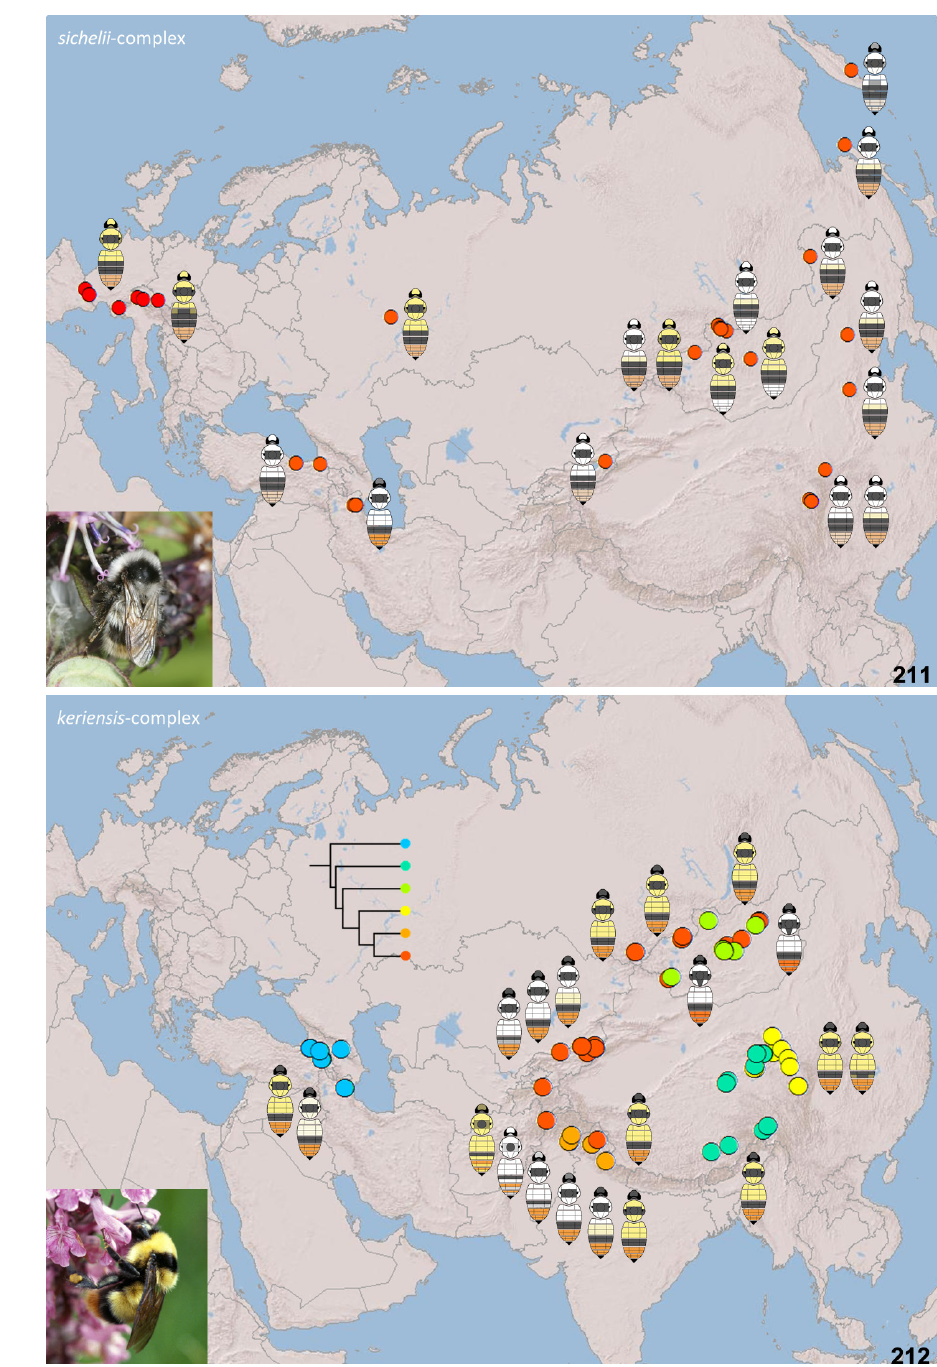
Figs 211–212. Maps of sequenced samples showing the most frequent colour patterns locally. 211 . The sichelii -complex, consisting of the single polytypic species B. sichelii Radoszkowski, 1859 (inset: B. sichelii worker, China-Neimenggu, photo PW). 212 . The keriensis -complex, consisting of B. alagesianus Reinig, 1930 stat. rev. (blue spots), B. tibeticus sp. nov. (dark green spots), B. incertoides Vogt, 1911 stat. rev. (light green spots), B. qilianensis sp. nov. (yellow spots), B. keriensis Morawitz, 1887 (orange spots), and B. separandus Vogt, 1909 stat. rev. (red spots) (inset: B.qilianensis sp. nov. queen, China-Sichuan, photo PW). Maps projected onto a sphere in ArcGIS using World_Shaded_Relief basemap © 2014 ESRI and showing boundaries between countries as recognised by the